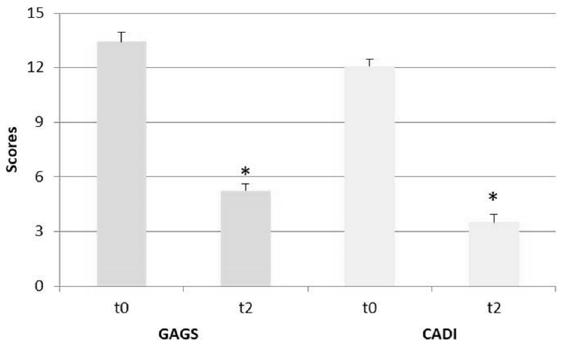
Figure 2. Berberine effectiveness on the amelioration of acne status. * p < 0.0001.